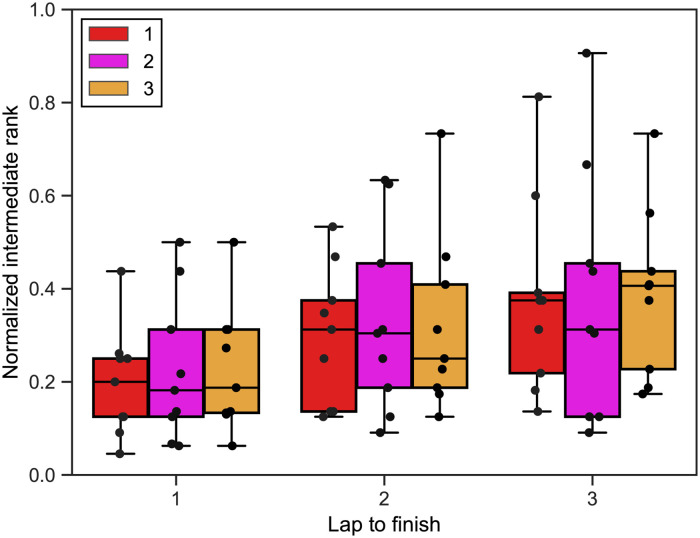
Relationships between the intermediate rank, finish rank, and laps to the finish, for the top three finishers.A circle represents the skater whose finish rank is indicated by the color of the bar in the background. We horizontally jittered the circles to avoid their overlapping.